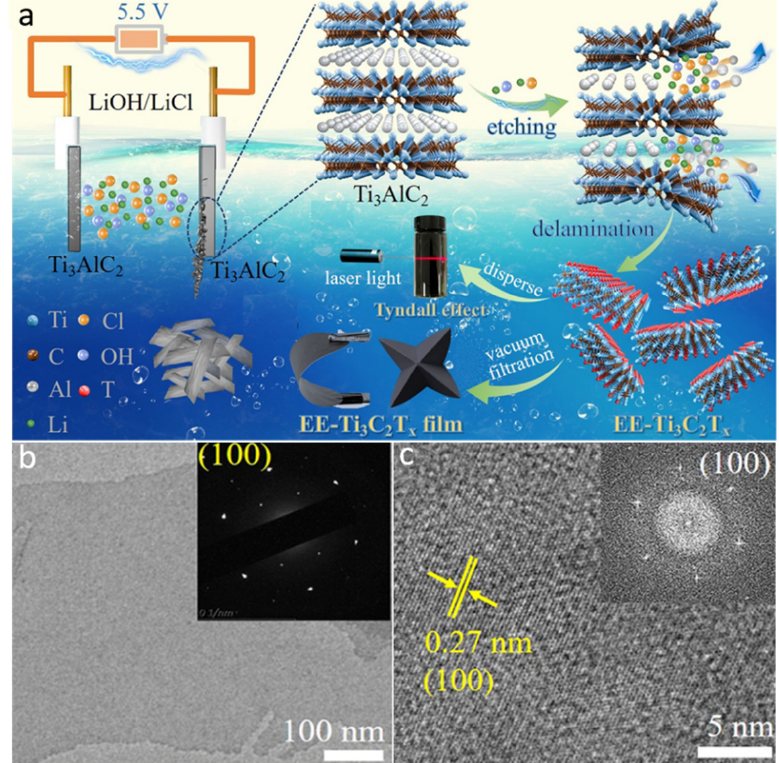
Figure 4. Scheme for the synthesis ( a ), TEM micrograph ( b ), and HR-TEM micrograph ( c ) of the fluoride-free Ti 3 C 2 T x MXene. Reproduced with permission from ref. [45] Copyright 2022, The American Chemical Society.